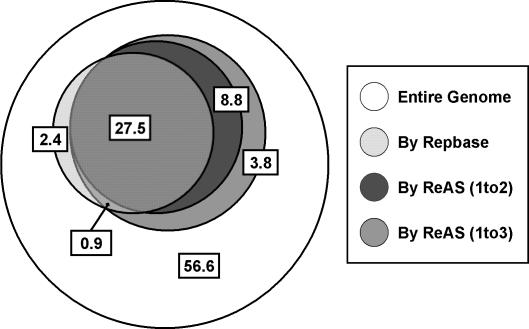
Masking of Entire Rice Genome by RepeatMaskerWe use different TE libraries and indicate the overlaps between these different results in a Venn diagram. ReAS (1to2) refers to the first two categories of Table 2 (Repbase and TE-related). ReAS (1to3) includes the third category (other repeats). Numbers are percentage of genome.